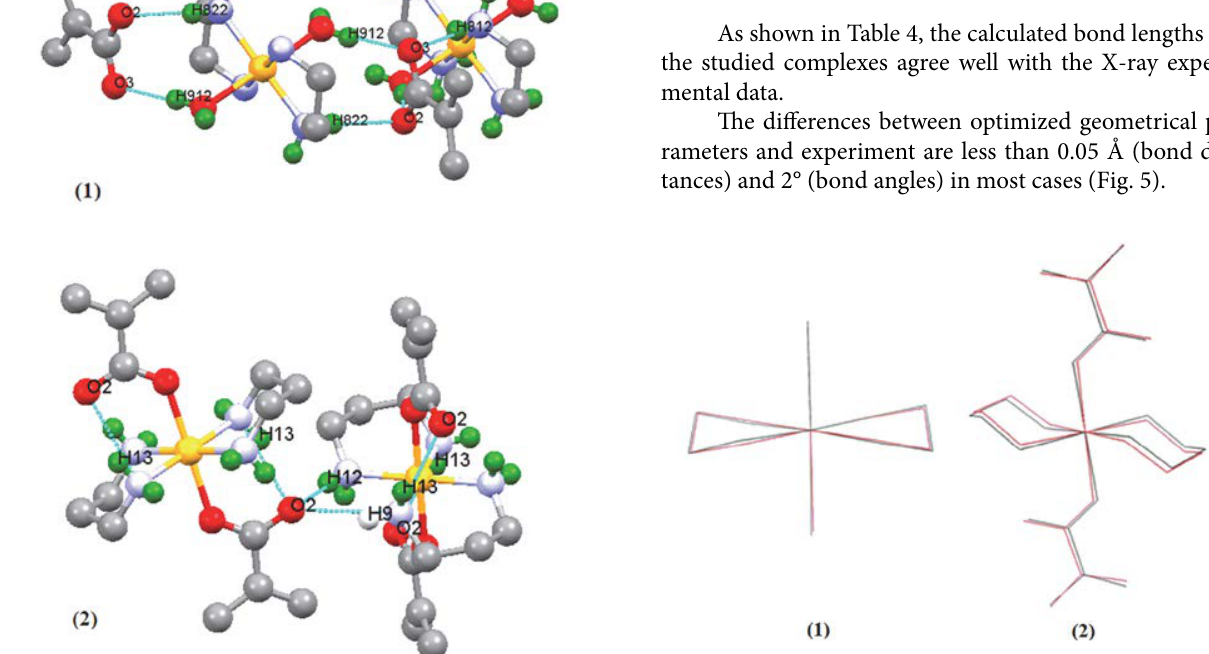
Fig. 5. Atom-by-atom superimposition of the calculated structures (black) over the X-ray structure (red); hydrogen atoms have been removed for